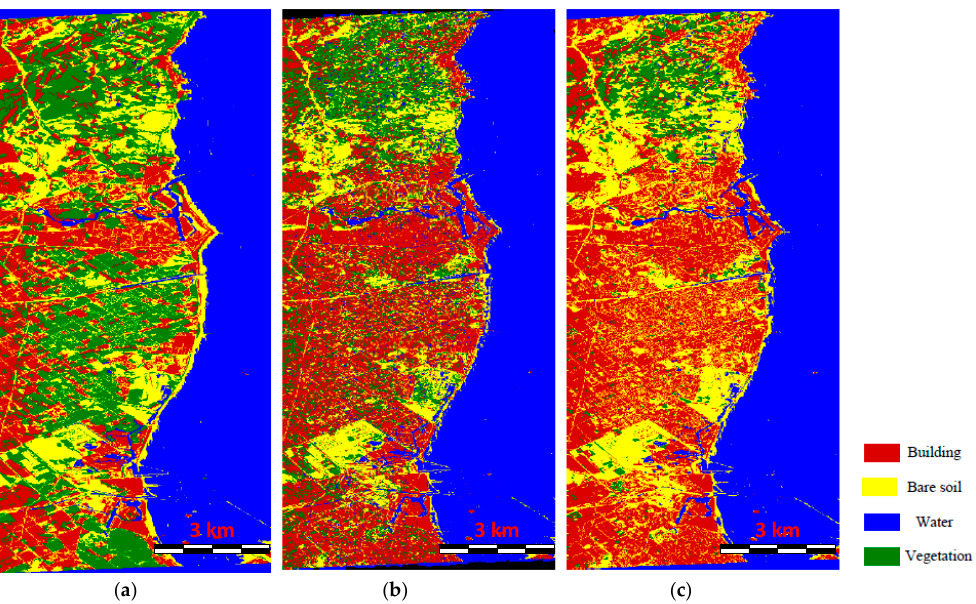
Figure 11. Classification results of the AIRSAR image with a different strategy: ( a ) result without the improved MCSM decomposition; ( b ) result without the superpixel-based processing strategy; ( c ) result without the feature dimensional reduction.